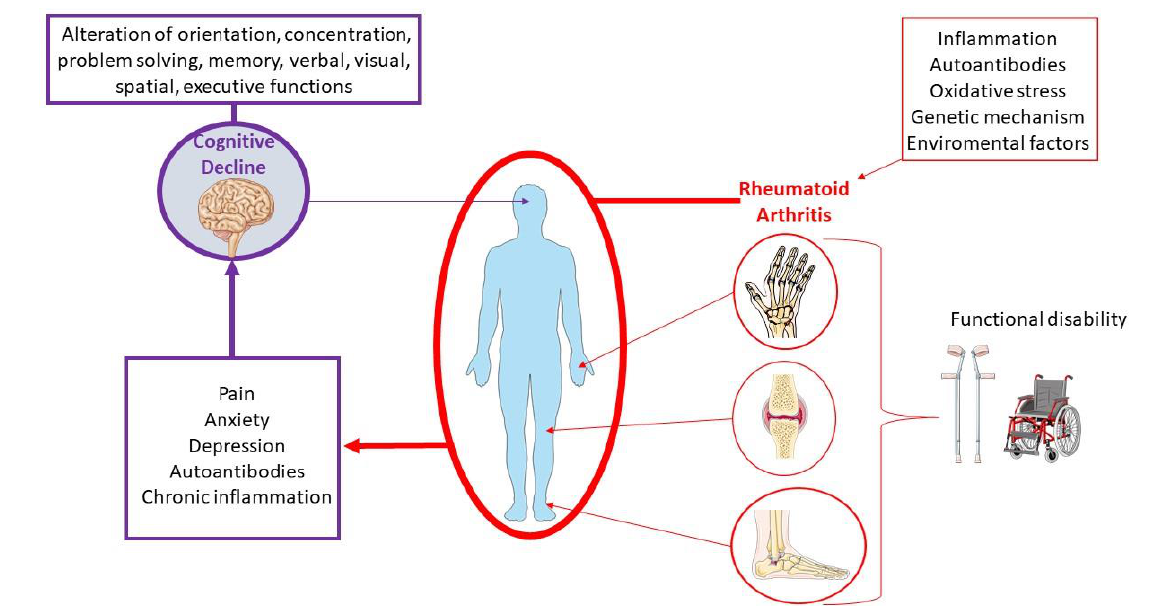
Figure 2. Multistep progression of rheumatoid arthritis to cognitive dysfunction.